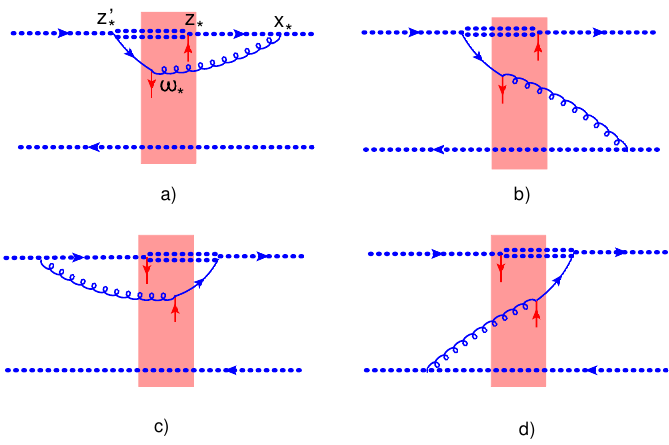
defined in eq. (3.9) using the quark- ij